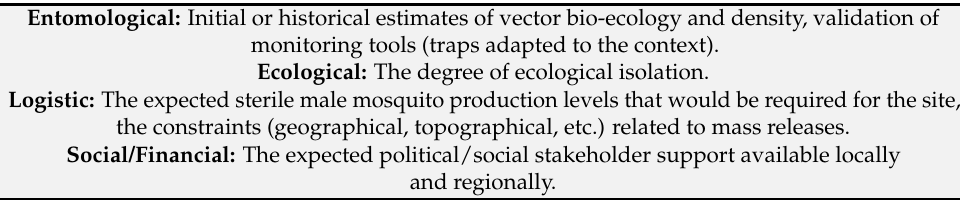
Table 3. Important criteria for selecting pilot study sites. Entomological: Initial or historical estimates of vector bio-ecology and density, validation of monitoring tools (traps adapted to the context). Ecological: The degree of ecological